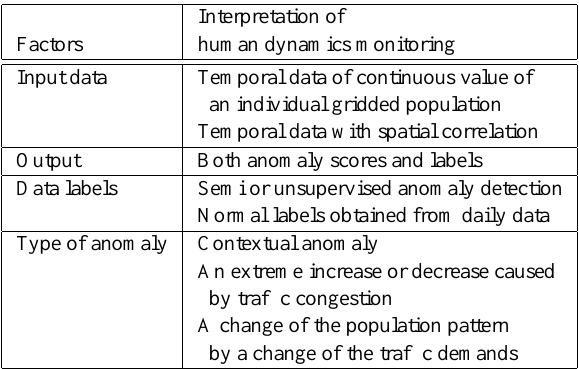
Table 2: Characteristics of the anomaly detection of human